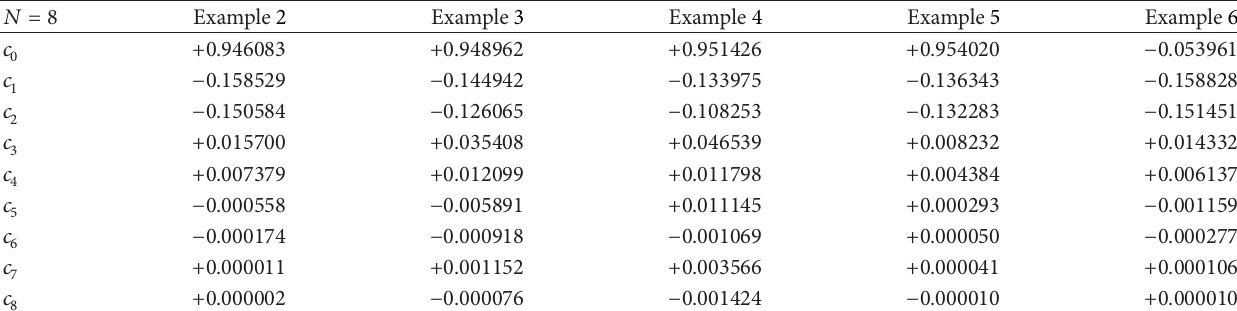
Table 5: Vanishing of the Bernoulli coefficients as the number of index is